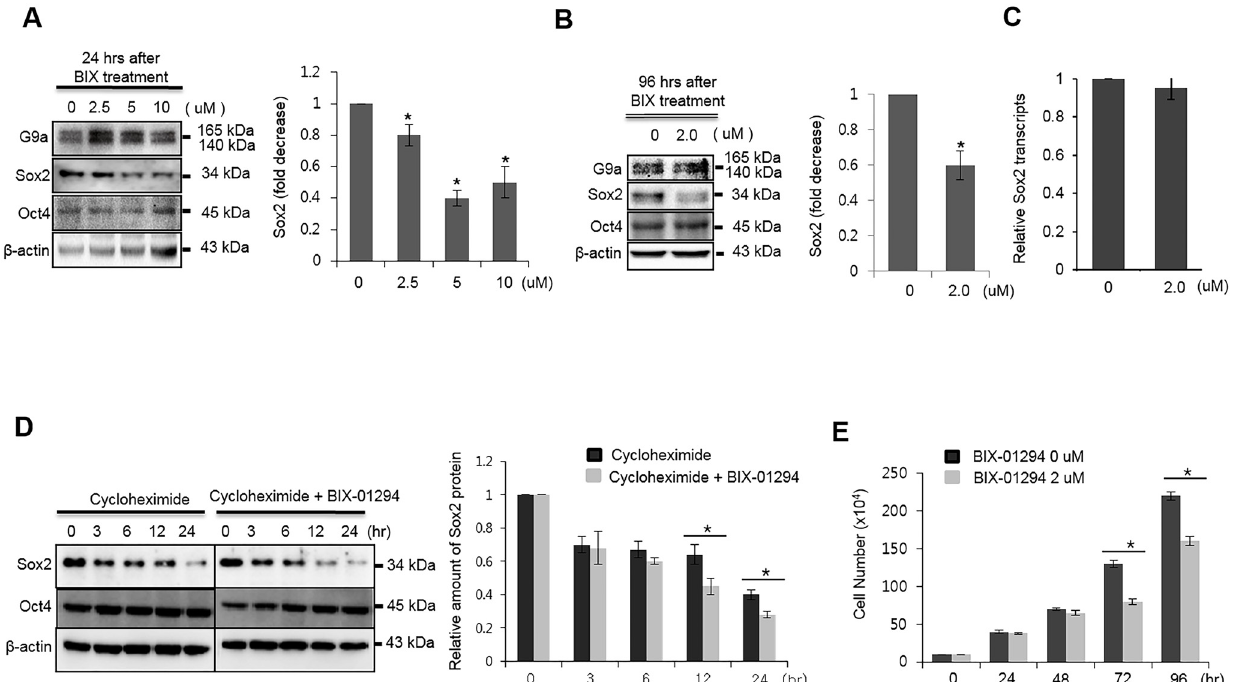
Fig 1. Chemical inhibition of G9a activity reduces the stability of Sox2 protein in MCF7 cells. (A) MCF7 cells were treated with the indicated doses of BIX-01294 for 24 h. Whole cell lysates were harvested and analyzed by immunoblotting with G9a-, Sox2-, and Oct4-specific antibodies. (B) MCF7 cells were treated with 0.2 μ M of BIX-01294 for 96 h, and whole cell lysates were analyzed for the expression of Sox2 and Oct4. (C) MCF7 cells were treated with 2.0 μ M BIX-01294 for 96 h, and the levels of Sox2 transcripts were analyzed by real-time RT-PCR analysis. mRNA levels were normalized to those of GAPDH. (D) Sox2 and Oct4 protein levels in MCF7 cells were analyzed by immunoblotting after cells were treated with 2.0 μ M BIX-01294 in the presence of the protein synthesis inhibitor, cycloheximide (5 μ M). The graph shows band intensity data normalized according to the controls and β -actin. (E) Cell growth was analyzed by counting cell numbers at the indicated times after treatment with 2.0 μ M BIX-01294. For quantitative analysis of the immunoblotting results, the mean density of the Sox2 band was measured with Multi Gauge V3.0 software, and the band density was divided by the density of β -actin to obtain the normalized band density. * P < 0.05 compared with the control group. Data are expressed as the mean ± SD and are representative of three independent experiments.